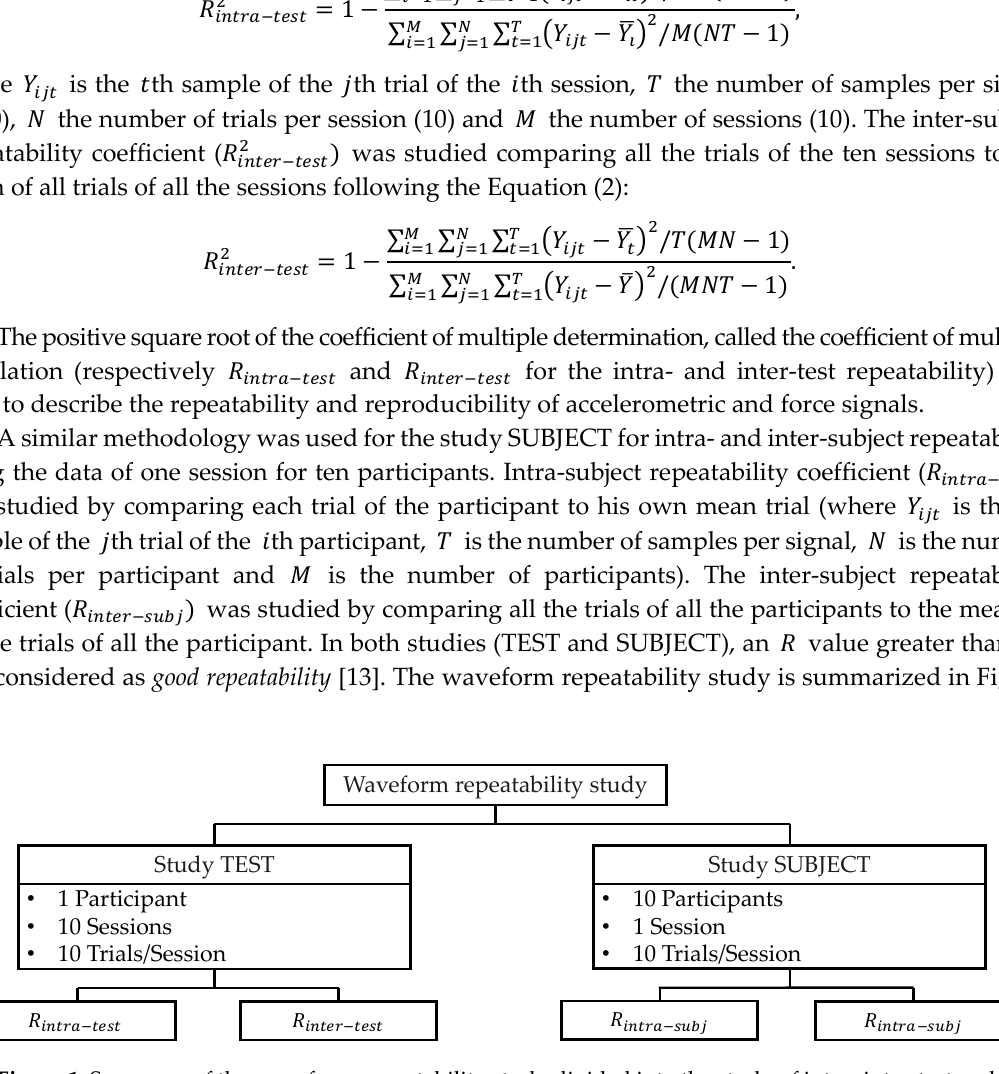
Figure 1. Summary of the waveform repeatability study divided into the study of intra- inter-test and the study of intra- and